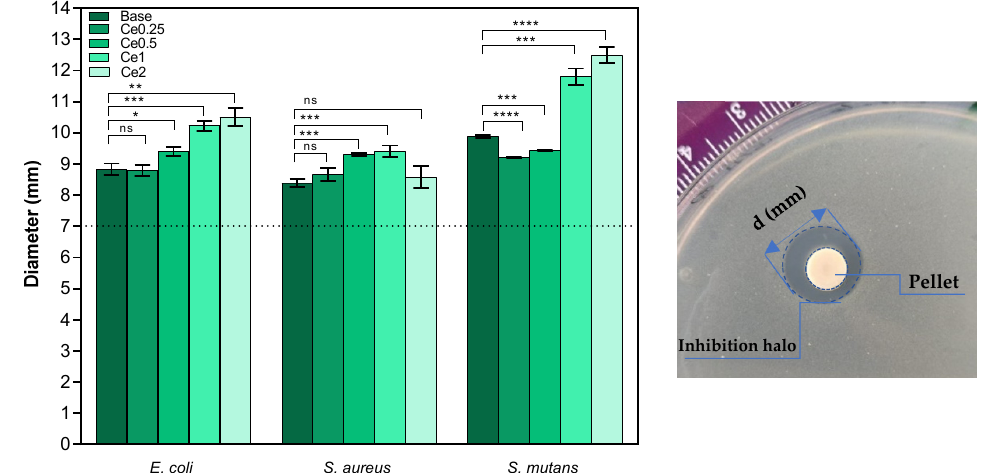
Figure 3. Measurements of inhibition halo diameter of all samples against Gram-negative ( E. coli ) and Gram-positive ( S. aureus and S. mutans ) bacteria, 24 h after incubation (ns: nonsignificant; * p ≤ 0.1; ** p ≤ 0.01; *** p ≤ 0.001; **** p ≤ 0.0001). Left side: Means of inhibition halo diameter for all microorganisms. Right side: example of a plate assay showing the inhibition halo of Ce2 pellet on S. mutans